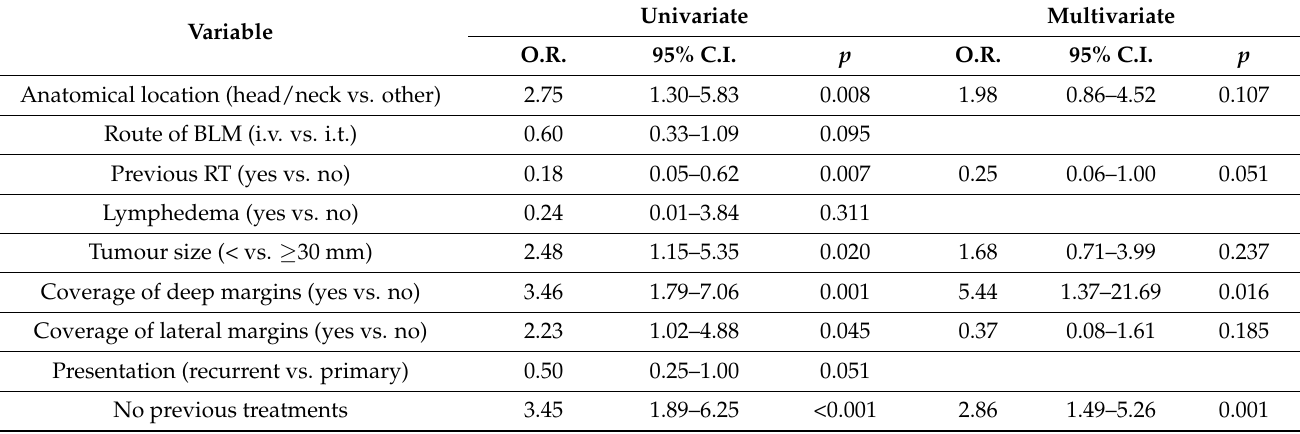
Table 4. Predictors of complete